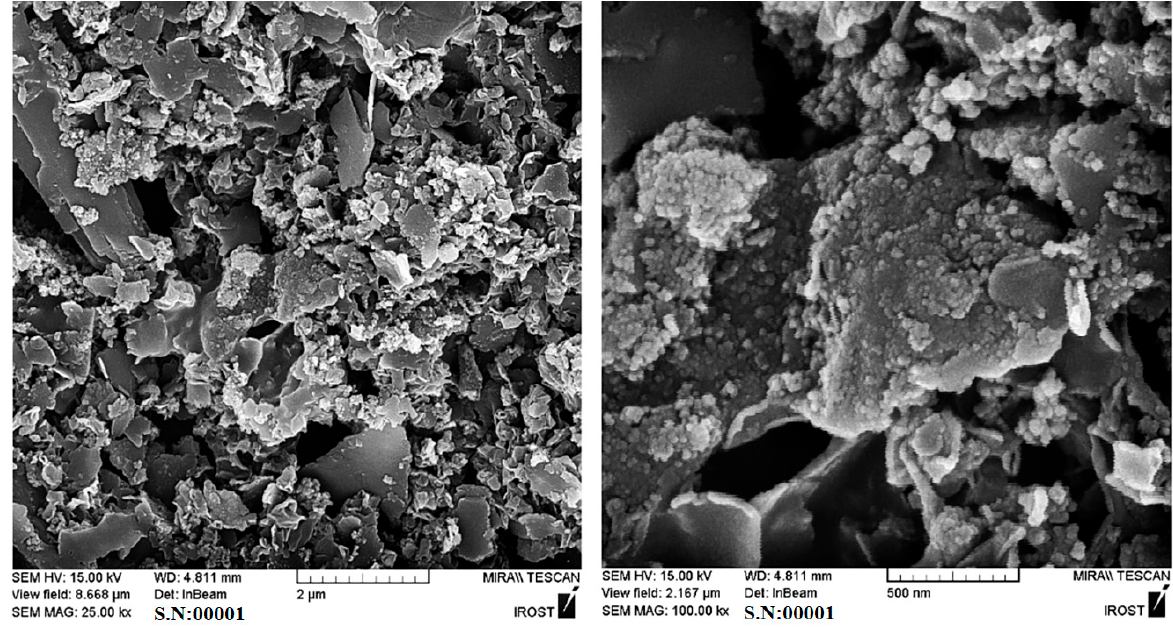
Figure 3. FESEM images of ( a ) GNPs and ( b ) Pt/S-ZrO 2 -GNP electrocatalyst.